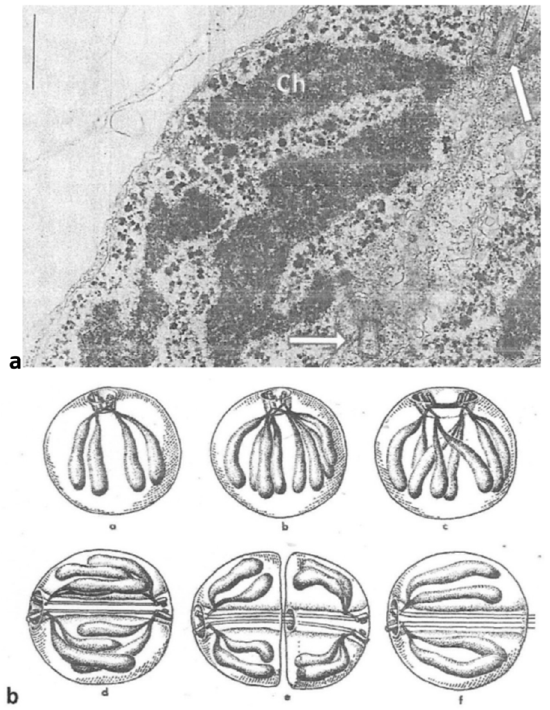
Figure 7. ( a ). Transmission electron microscopic ultrathin section showing separating chromosomes (Ch) and centrioles (white arrows). Scale bar = 0.25 µ m. ( b ). Line drawings of the different stages of chromosome segregation a, b, c. Late stages of chromosome segregation. Central spindle in cytoplasmic channel throughout the nucleus, d. Division of nucleus, e. Early daughter nucleus with persisting channel and microtubules, f. Reprinted/adapted with permission from Ref. [17].